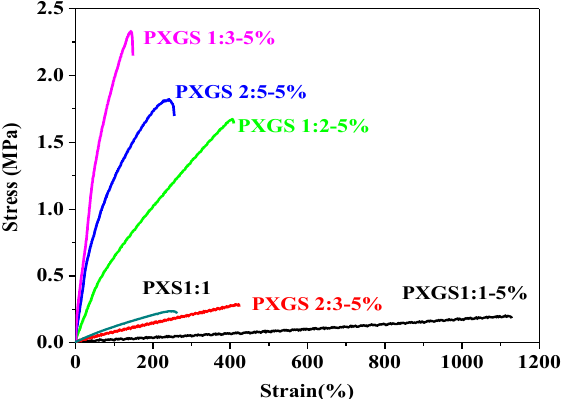
Figure 5. Stress-strain curves of PXGS with different monomer ratios and PXS